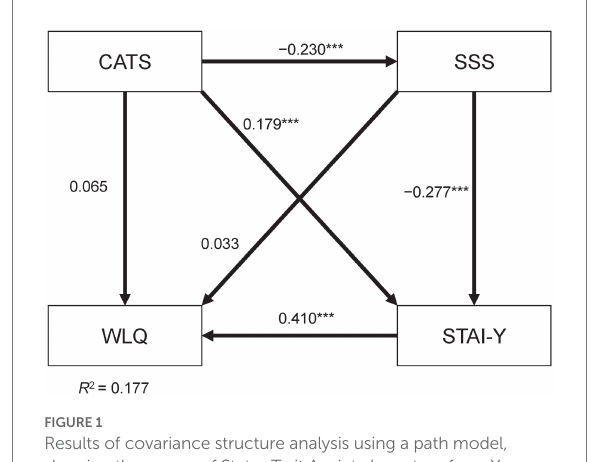
FIGURE 1 Results of covariance structure analysis using a path model, showing the scores of State–Trait Anxiety Inventory form Y (STAI-Y), Child Abuse and Trauma Scale (CATS), Subjective Social Status (SSS), and Work Limitations Questionnaire (WLQ) of 469 adult workers. The numbers beside the arrows indicate the direct standardized path coefficients. Indirect effects through the variables are explained in the Results section. *** p <